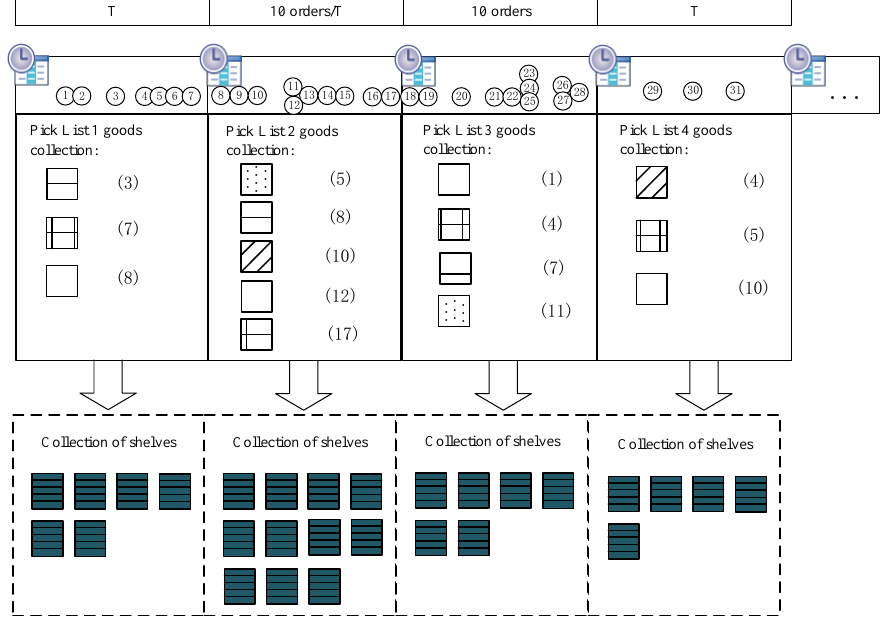
Figure 1. Hybrid time windows divide order batches to generate pick